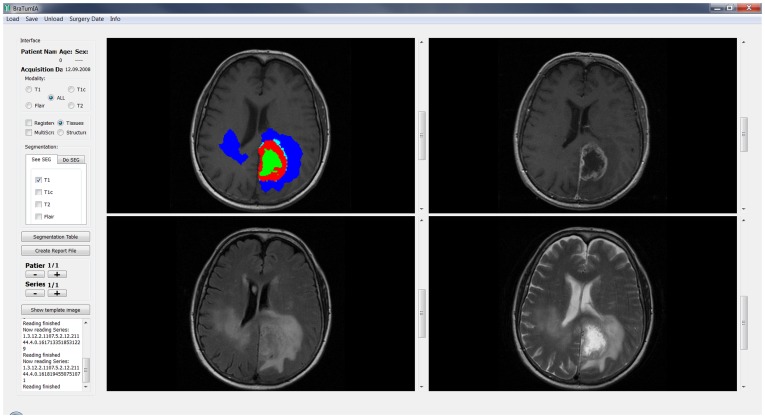
Graphical user interface of the BraTumIA software.Data can be loaded from the buttons at the top, the left side offers different options for processing and visualization and the largest part of the screen depicts the different MRI modalities with optional overlay of the segmentation results.